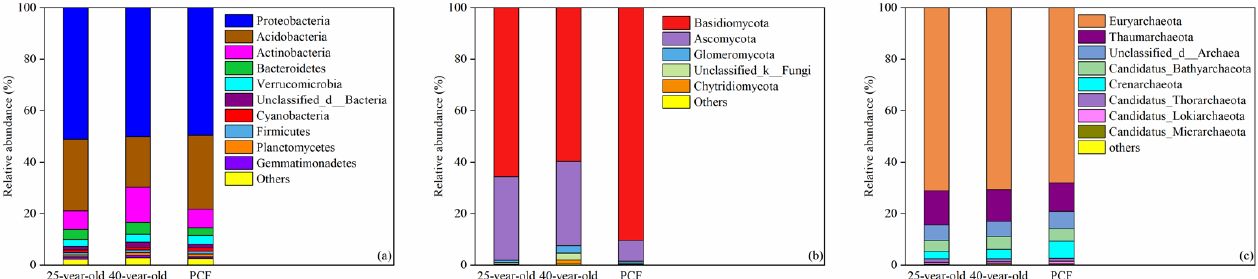
Figure 1. Taxonomic proportions in the bacterial ( a ), fungal ( b ) and archaeal ( c ) communities at the phylum level. 25-year-old, 40-year-old and PCF represent the 25-year-old P. rubescens plantation, 40-year-old P. rubescens plantation and the primeval coniferous forest, respectively. Others represent the sum of phyla that ccount for less than 1% in relative abundance.